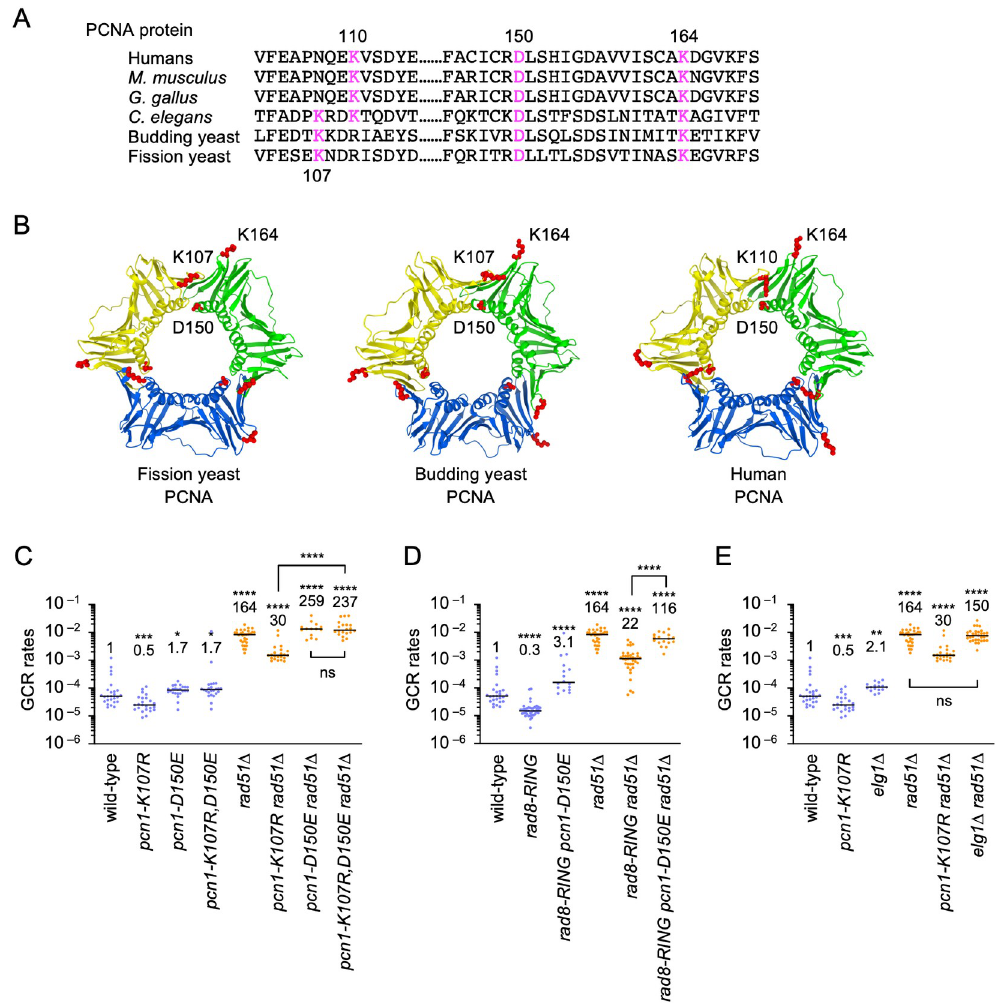
Fig 5. An interface mutation D150E bypasses the requirement of PCNA K107 and Rad8 ubiquitin ligase for GCRs. (A) PCNA amino acid sequences that contain K107, K110, D150, or K164. (B) Structure of fission yeast PCNA was computed by the SWISS-MODEL program using an automated mode [91]. X-ray structure of fission yeast PCNA in a complex with an Spd1 peptide (PDB code 6qh1) was used as the template. X-ray structure of budding yeast PCNA (PDB code 1plr) and human PCNA (PDB code 1vym) are shown. Positions of PCNA K107, K110, D150, and K164 residues (red) were drawn using Mol � Viewer (https://molstar.org/). (C) GCR rates of the wild-type, pcn1-K107R , pcn1-D150E , pcn1-K107R , D150E , rad51 Δ , pcn1-K107R rad51 Δ , pcn1-D150E rad51 Δ , and pcn1-K107R , D150E rad51 Δ strains (TNF5369, 6738, 7724, 7727, 5411, 6761, 7744, and 7747, respectively). (D) GCR rates of the wild-type, rad8-RING , rad8-RING pcn1-D150E , rad51 Δ , rad8-RING rad51 Δ , and rad8-RING pcn1-D150E rad51 Δ strains (TNF5369, 6207, 7750, 5411, 6219, and 7773, respectively). (E) GCR rates of the wild-type, pcn1-K107R , elg1 Δ , rad51 Δ , pcn1-K107R rad51 Δ , and elg1 Δ rad51 Δ strains (TNF5369, 6738, 7696, 5411, 6761, and 7741, respectively). The two-tailed Mann-Whitney test. Non-significant (ns) P > 0.05; � P < 0.05; �� P < 0.01; ��� P < 0.001; ���� P < 0.0001. Numerical source data underlying the graphs shown in (C-E) are provided respectively in Tables J, K, and L in S1 File.